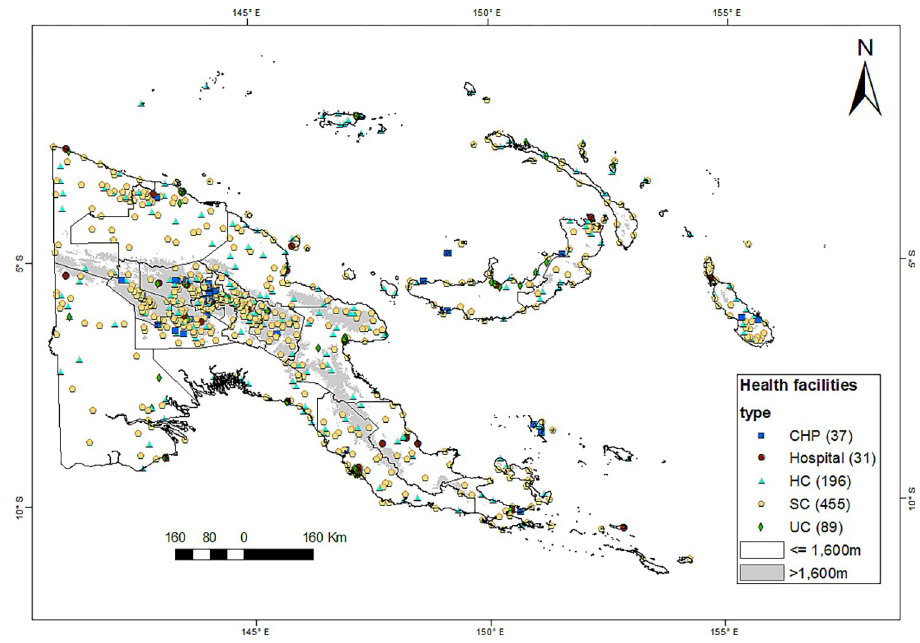
Fig 2. Distribution of health facilities in Papua New Guinea. Locations of 808 health facilities: HC = Health Centre; SC = Sub-Health Centre; CHP = Community Health Post; UC = Urban Clinic. Source of the map base layer: WFP-World Food Programme, 2019. Map created by the authors using a licensed ArcGIS Desktop 10.5 software from Esri (http://www.arcgis.com/).